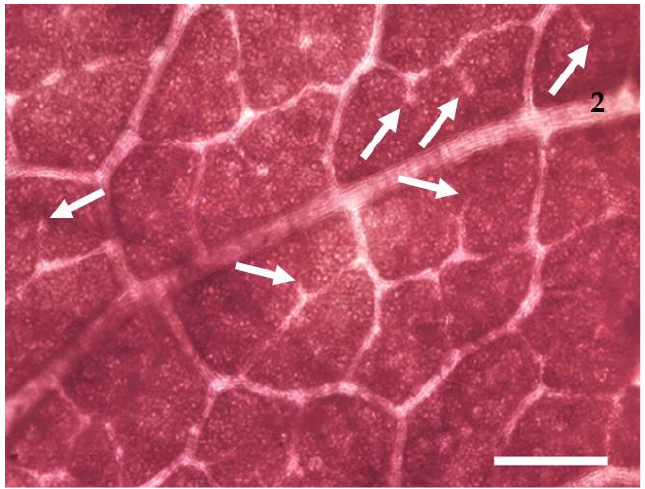
Figure 7. Light microscopy views of V. vinifera ‘Falanghina’ leaf lamina sample with arrows pointing to the FVEA (2, second-order vein). Bar = 300 µm.